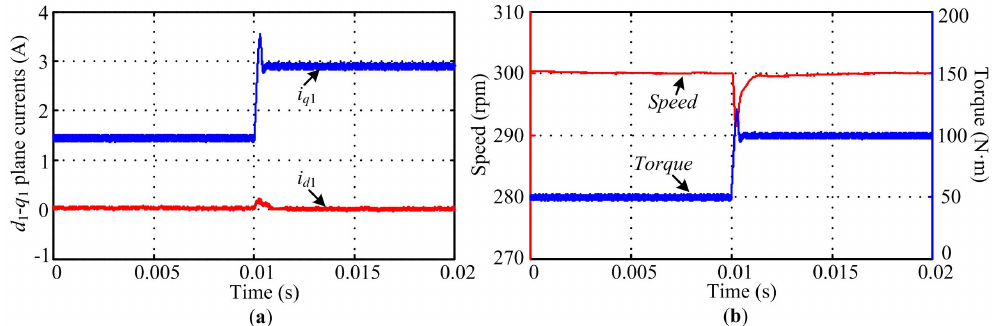
Figure 9. Simulation evaluation of start-up performance. ( a ) Phase currents response; ( b ) Speed and torque response.